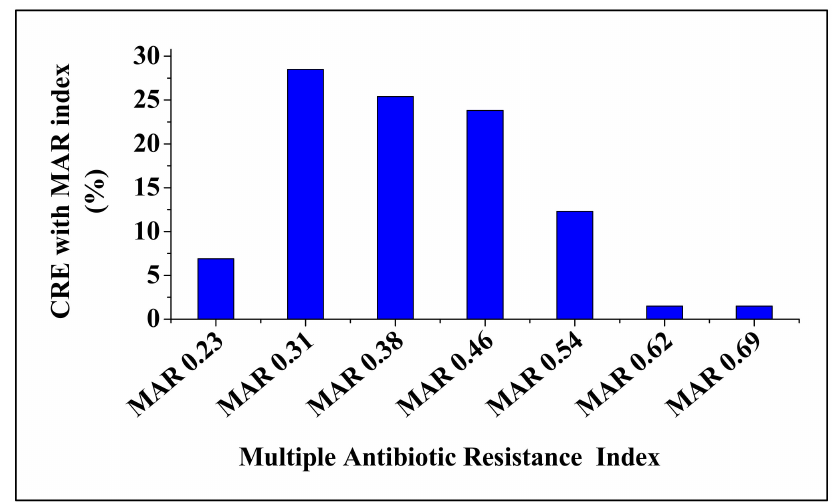
Figure 4. Mean frequency of multiple antibiotic resistance profiles of CRE strains.